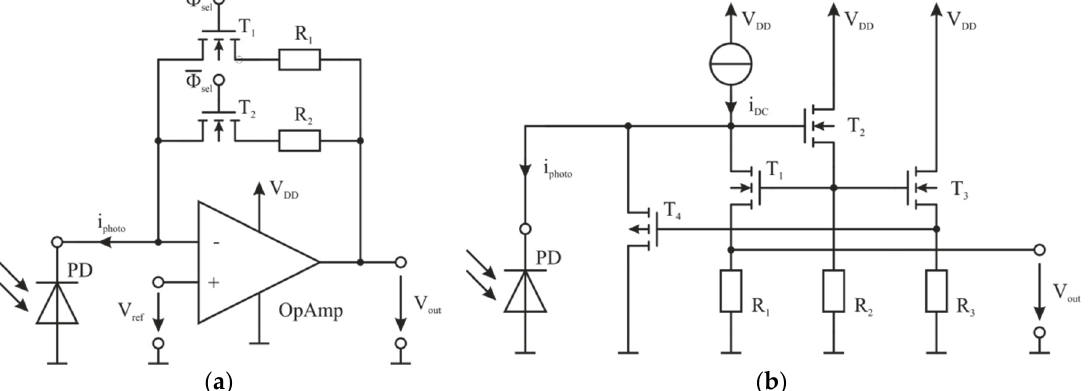
Figure 4. Amplification stage: ( a ) Transimpedance and ( b ) Regulated Cascode